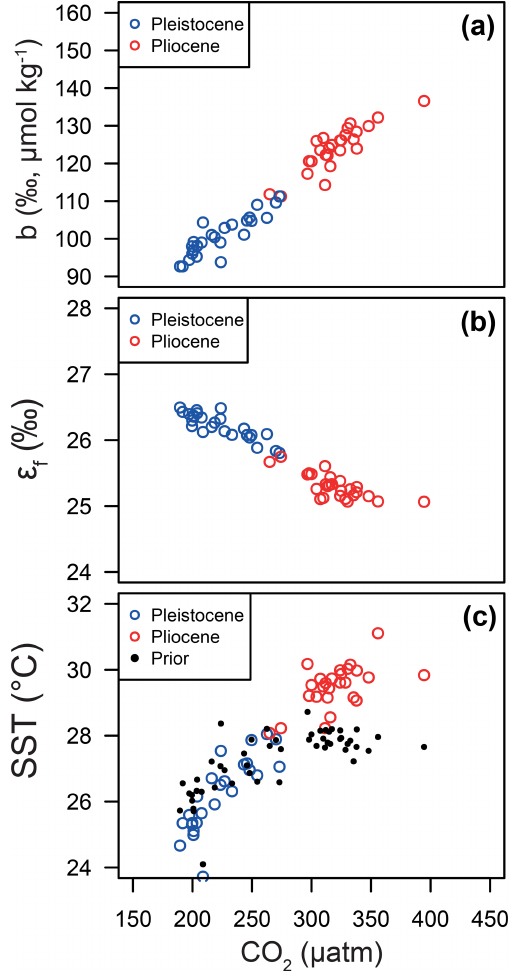
Figure 10. Relationships between CO 2 and (a) the b term, (b) ε f and (c) SST. In each panel, the median of each posterior distribu- tion is shown in red for the Pliocene and blue for the Pleistocene. Note that the CO 2 for each data point is either from the ice core or CO for the Pleistocene and Pliocene, respectively. The 2( δ 11 Bplank) linear patterns that emerge here essentially represent the relation- ships of the Bidigare et al. (1997) approach given our otherwise invariant ε p .